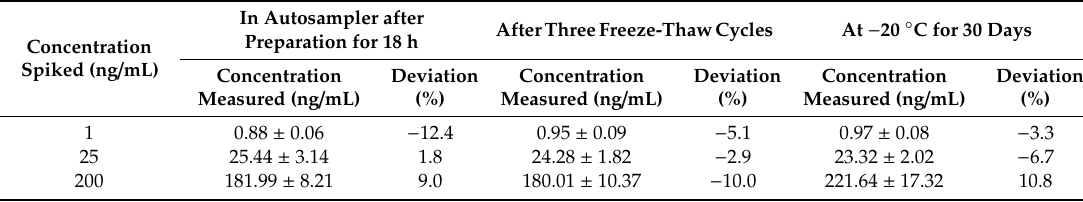
Table 4. The stability of celastrol in rat plasma ( n =